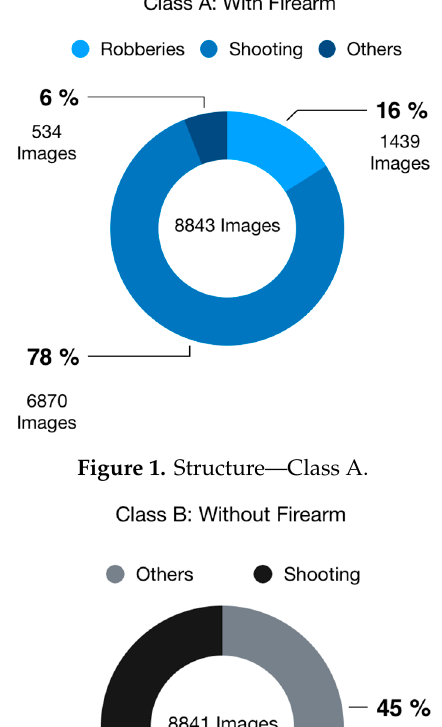
Figure 2. Structure—Class B.